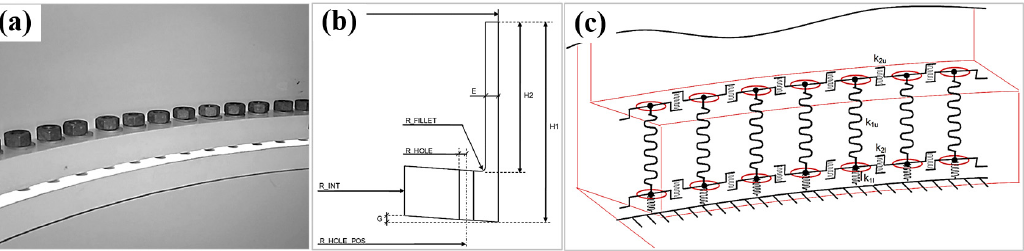
Figure 7. Parametric model of elastic interaction developed by Abasolo [46]: ( a ) physical drawing of the flange bolt array; ( b ) flange feature dimensions; ( c ) elastic interaction equivalent model.